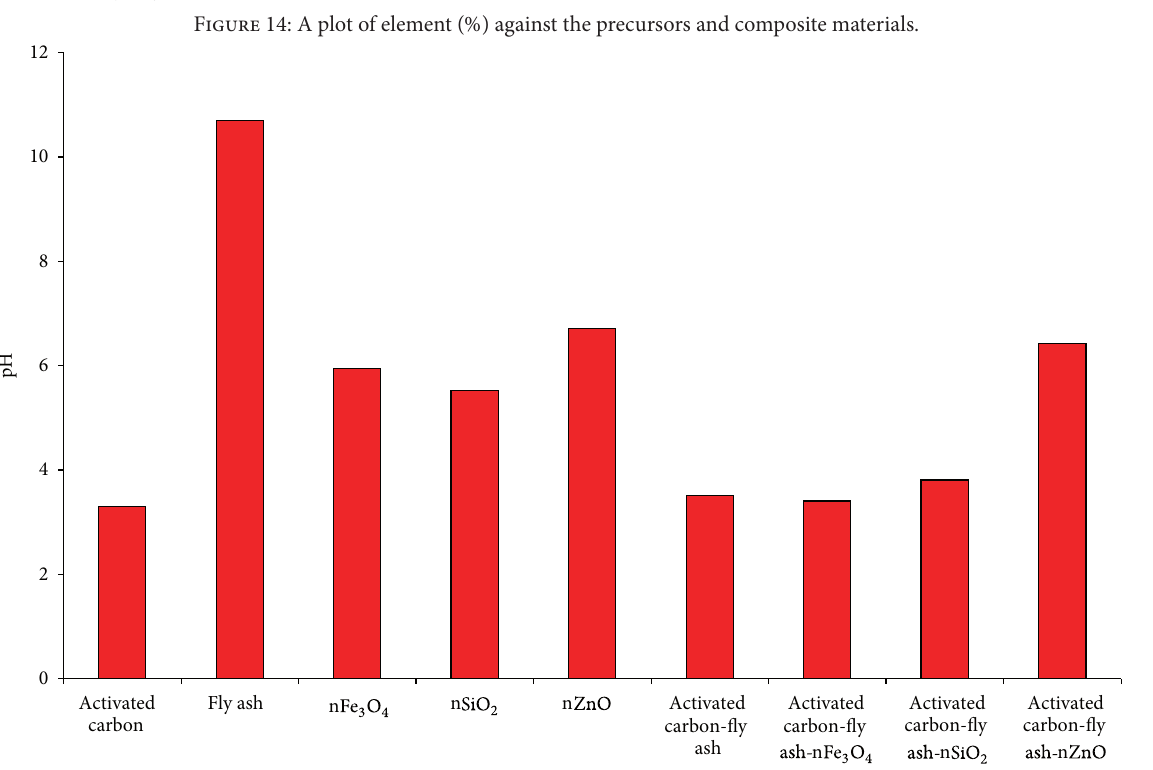
F 14: A plot of element (